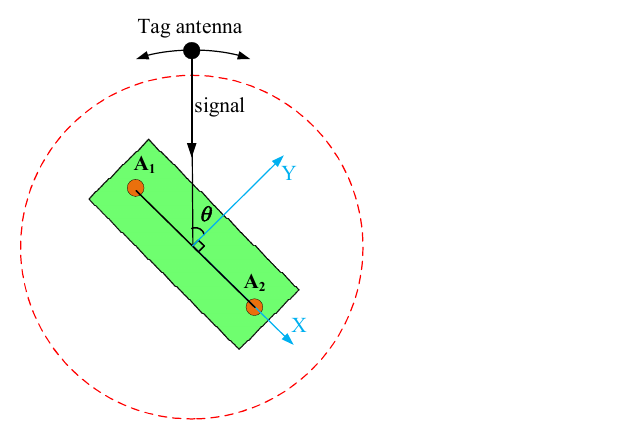
Figure 4. Scenario 3: Tag antenna illuminates anchor antennas in varying DOAs.